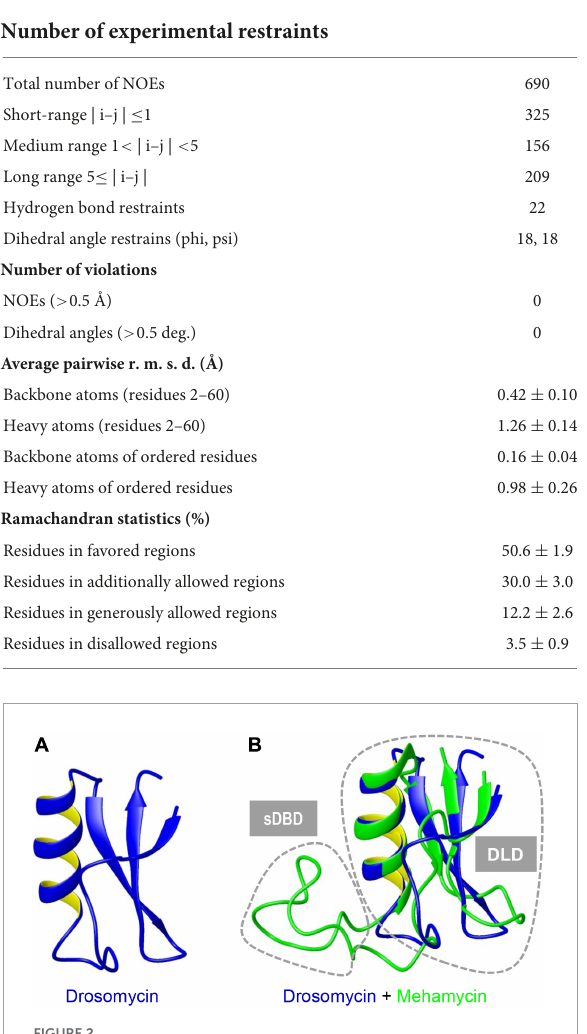
TABLE 1 Nuclear magnetic resonance (NMR)-derived constraints and structural statistics of the final 20 coordinates.